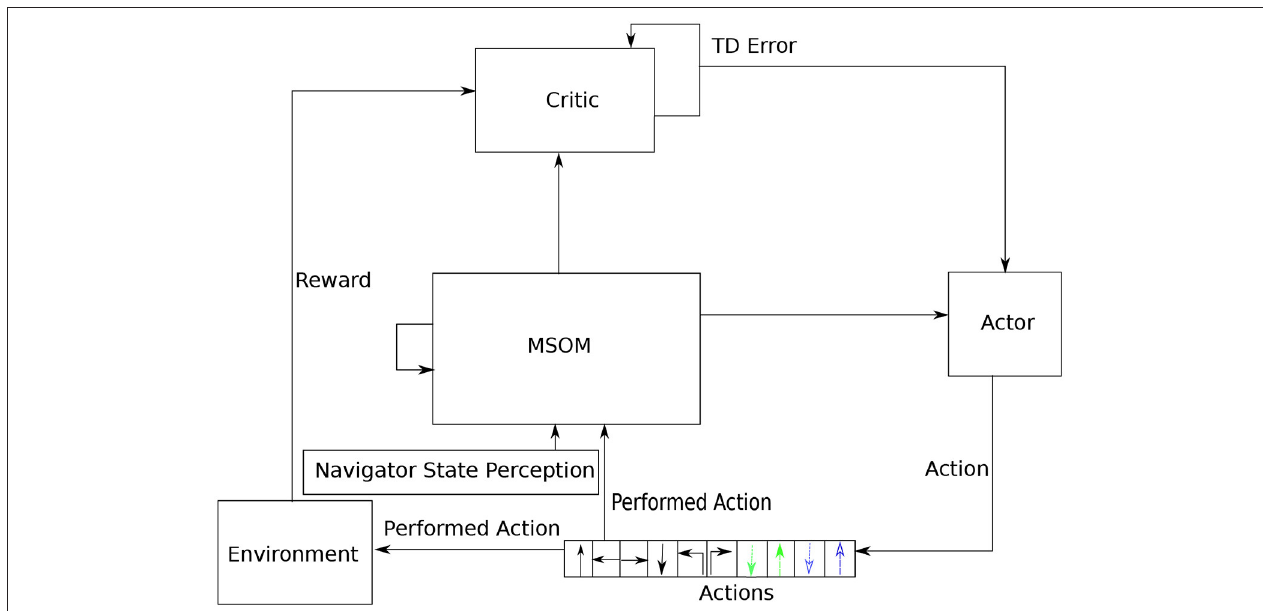
FIGURE 5 | Architecture of the proposed articulated goal-oriented learning model, where denotes translating forward directly, denotes translating left directly, ↑ ← → denotes translating right directly and denotes translating back directly. Orientating movements are represented as (cid:30) : orientating 90 ◦ counter-clockwise and (cid:31) : ↓ orientating 90 ◦ clockwise. The dashed colored lines stand for bending and unbending movements. First, the MSOM learns stable representations of object locations using the model presented in section 2.3. Then, based on the learned representations in MSOM, an actor critic is employed to achieve the reinforcement learning. When the agent is in one context, MSOM derives an activity pattern. The critic computes the temporal difference (TD) error δ (line 16 in Algorithm 1) based on the current activity pattern and the received reward from the environment (i.e., the 3D object being explored). This TD error is used for updating both the critic (line 17 in Algorithm 1) and the actor (line 18 in Algorithm 1). The actor predicts an action for the agent to perform for reaching a goal on the 3D